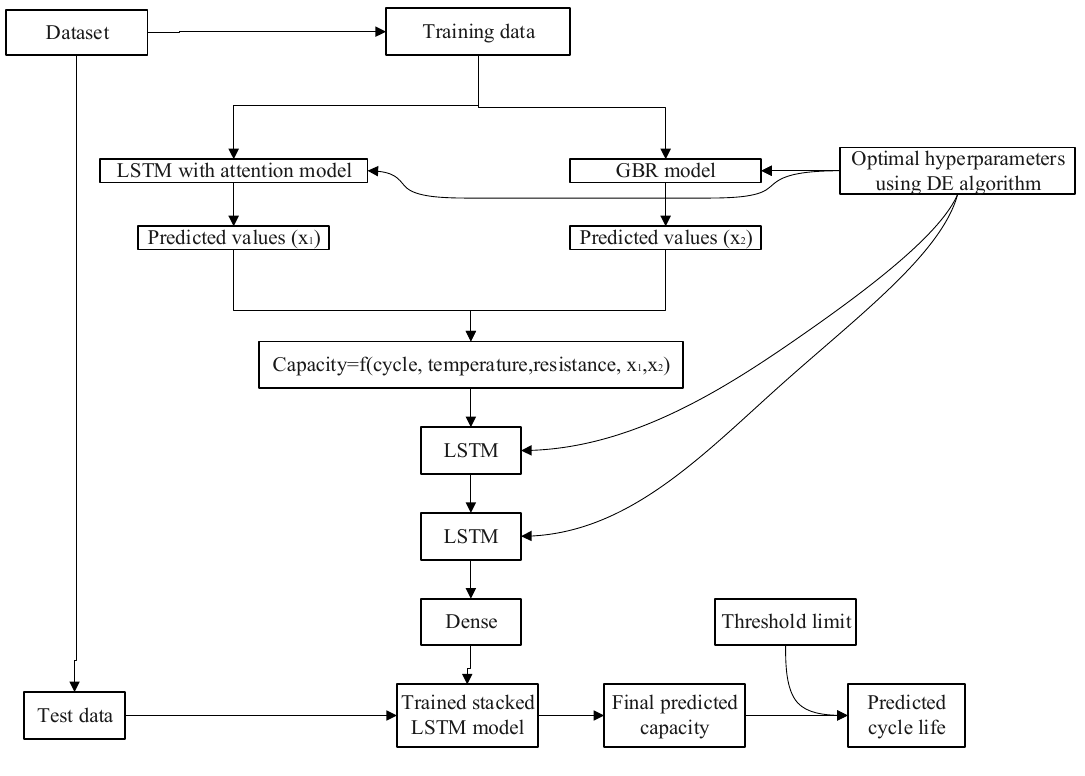
Figure 2. The flowchart of the proposed model.